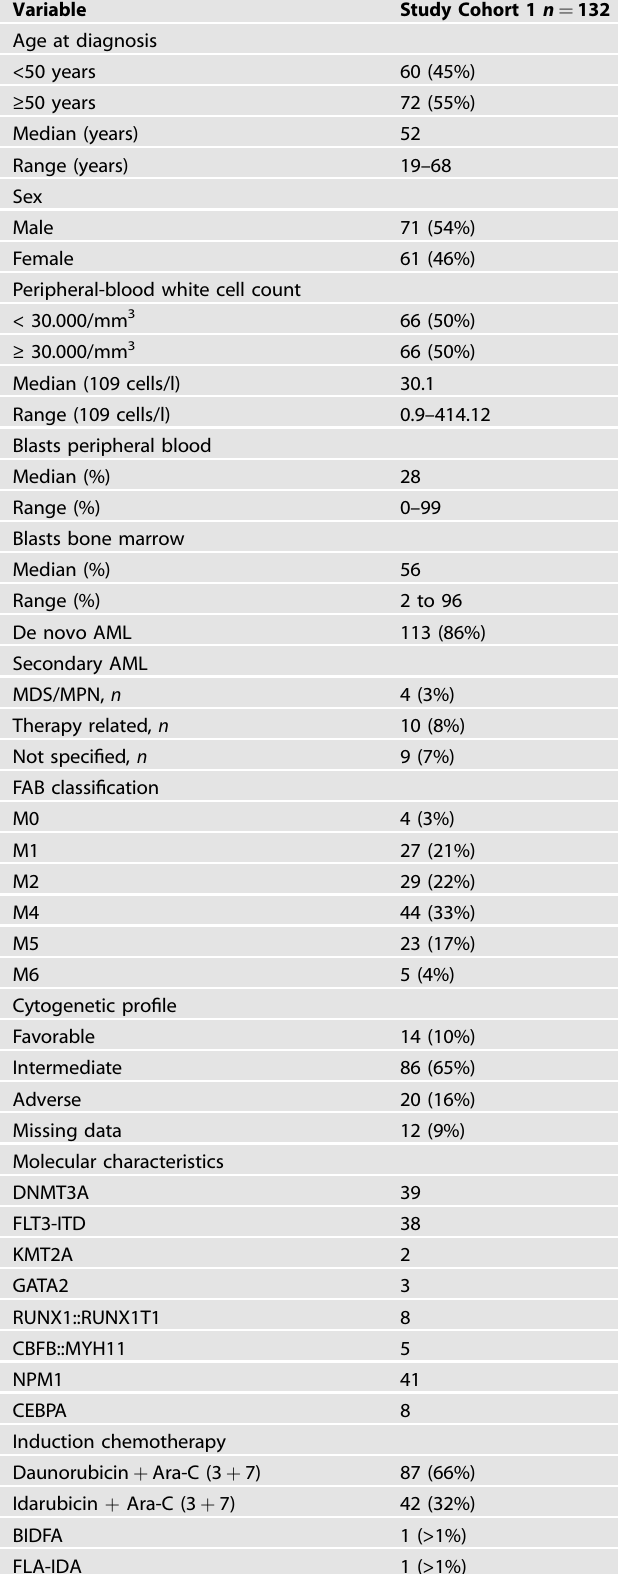
Table 1. Main clinical and biological characteristics of AML patients from Study Cohort